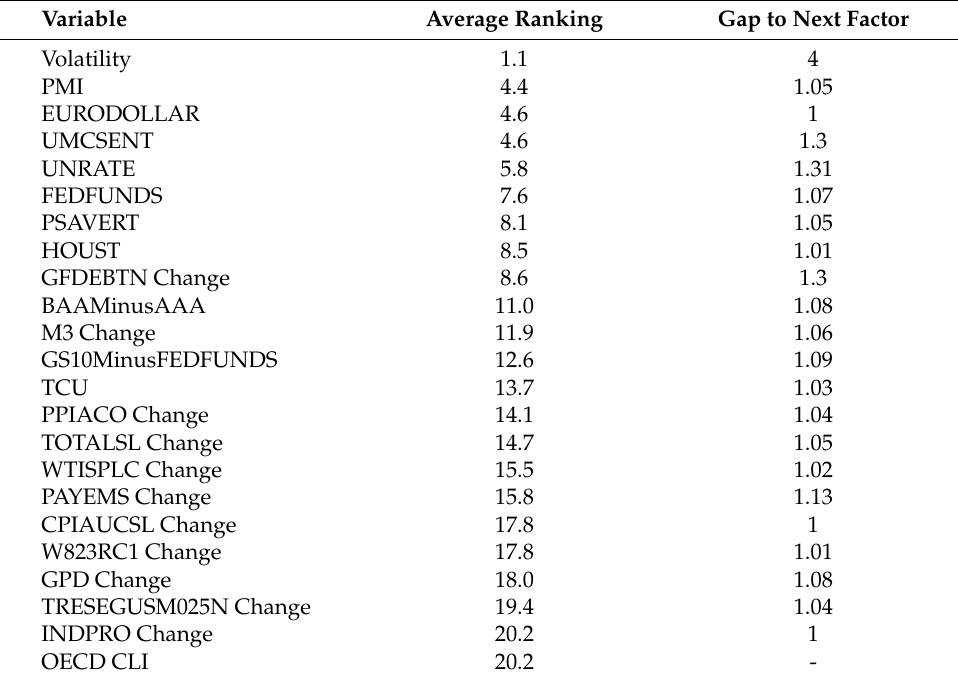
Table 2. Selection with initial S = ∅ (Model 1).